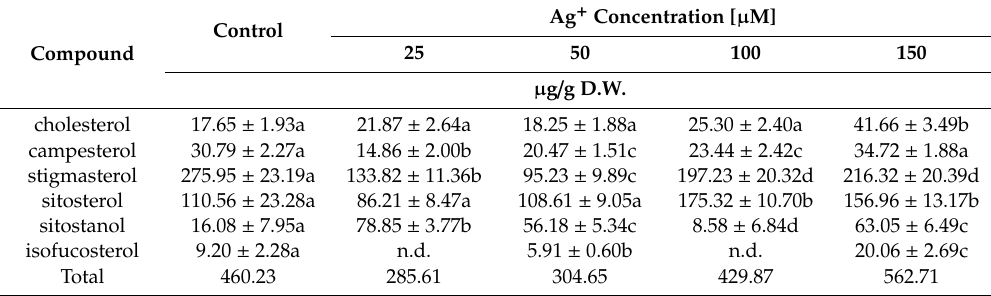
Table 1. The content of sterols in line CC16 hairy root tissue after treatment with Ag + ions.